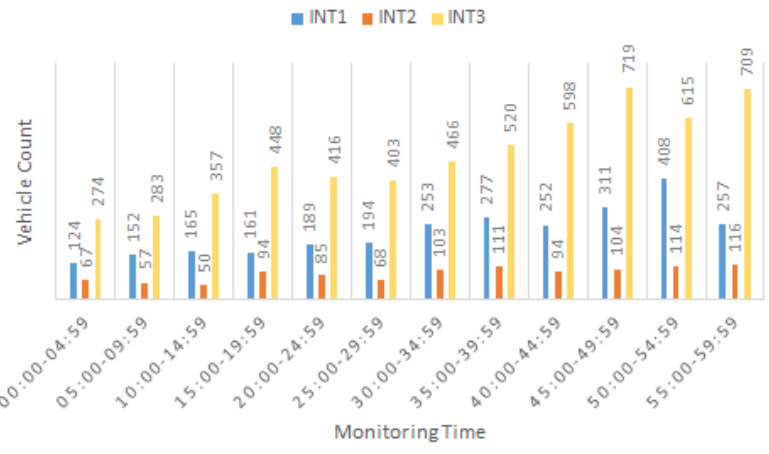
Figure 7. Branch-thru (BT) count estimation in 5-min